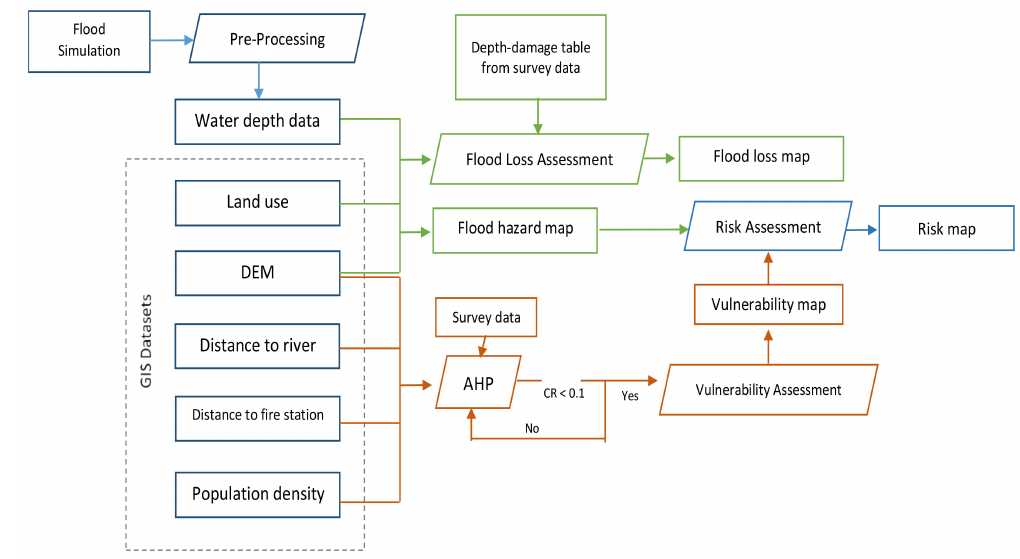
Figure 1. Flowchart of the GIS-based flood loss and risk